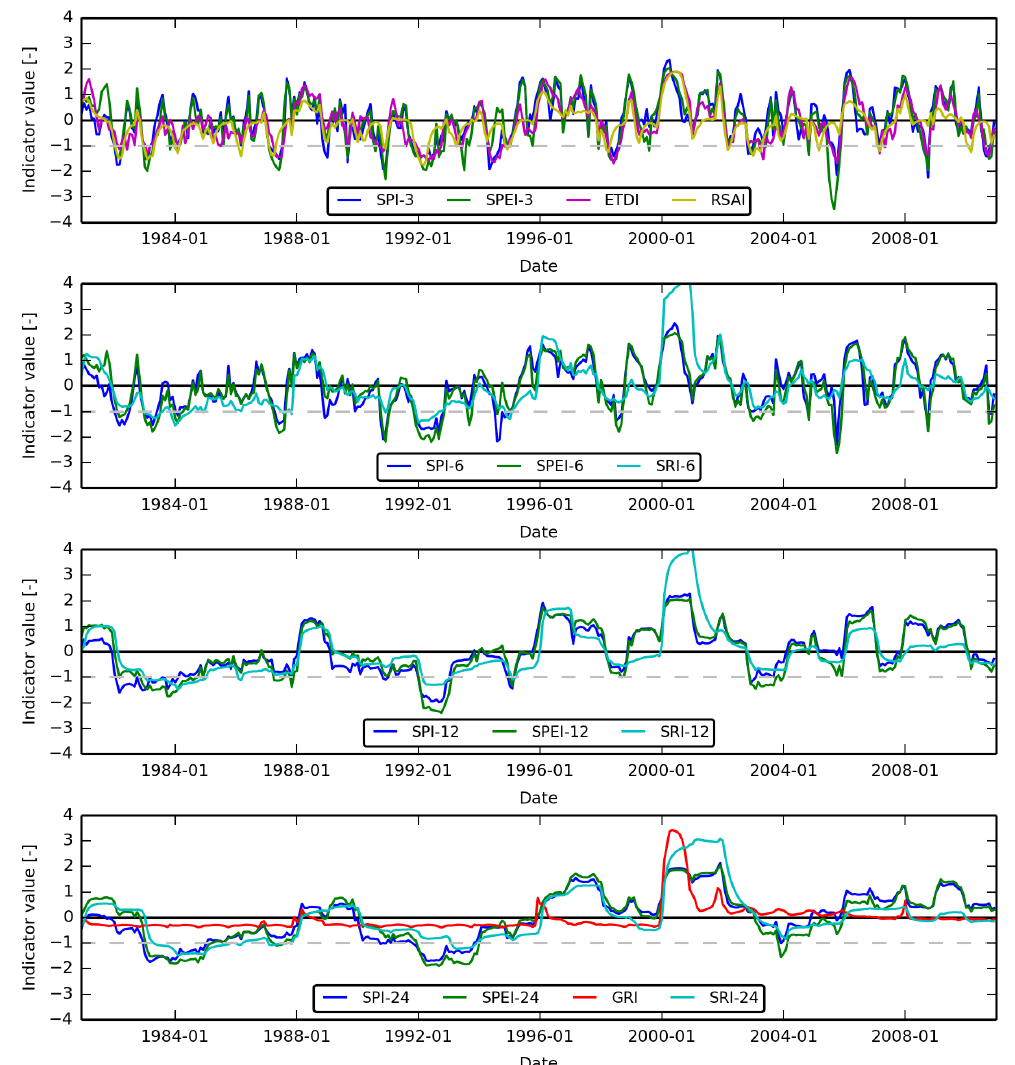
Figure 7. Same as Fig. 6, but for subbasin